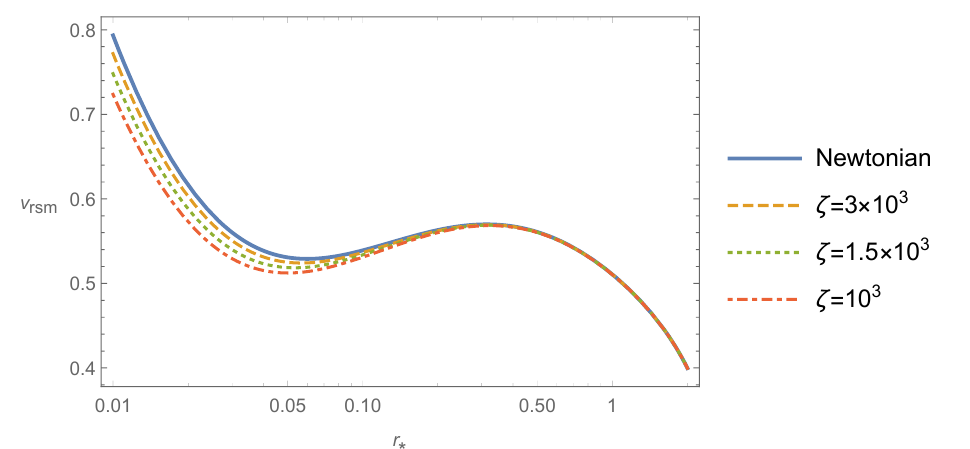
Figure 3. v rms as function of r ∗ for β = − 0.1, µ = 0.004. Solid line corresponds to Newtonian solution and dashed lines to post-Newtonian solutions for ζ = 1.0 × 10 3 ;1.5 × 10 3 ;3.0 × 10 3